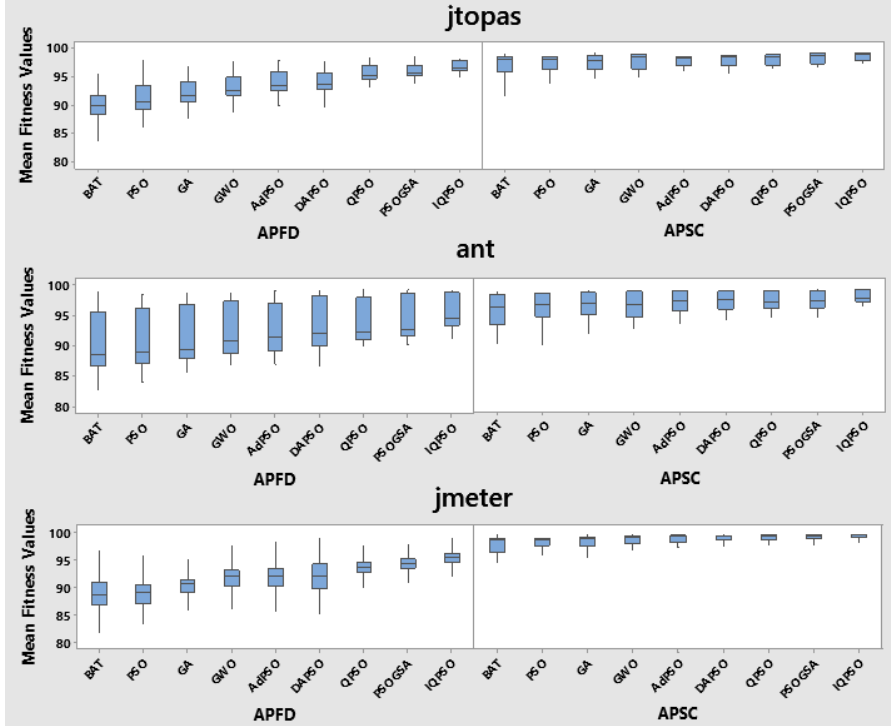
Figure 2. Boxplots of algorithms for fault and statement coverages of